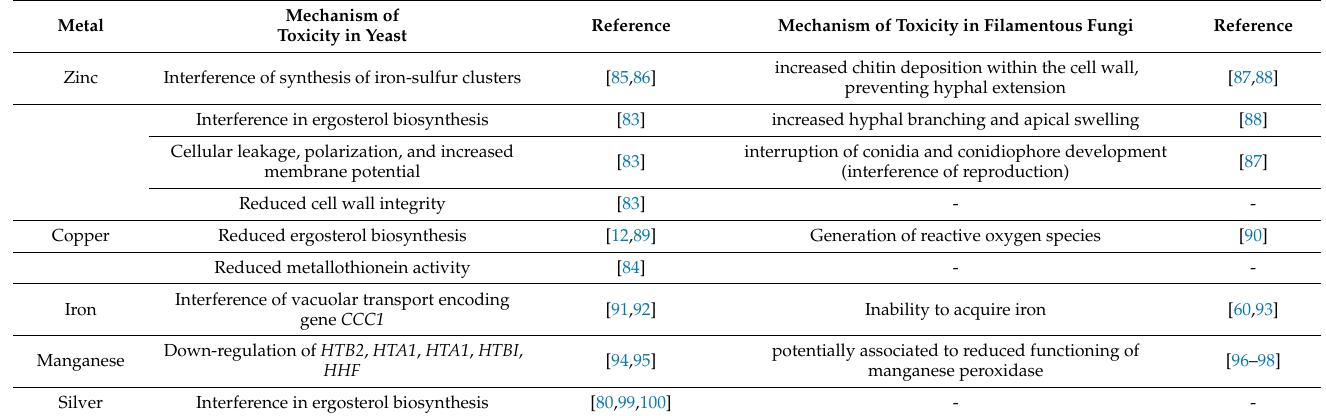
Table 2. Mechanisms of toxicity in yeast and filamentous fungi.